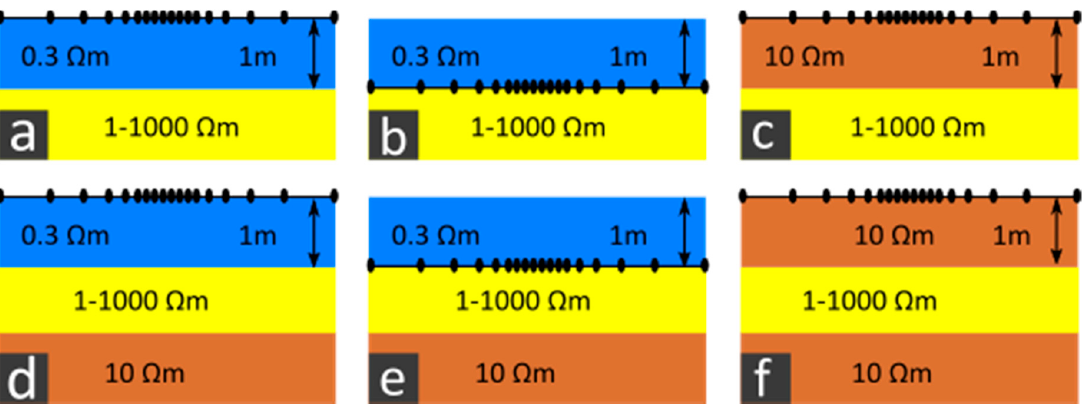
Figure 5. Subsurface models used for forward calculations in the 2L case for ( a ) a shallow water environment, setup F, ( b ) a shallow water environment, setup S and ( c ) an onshore environment, as well as in the 3L case for ( d ) a shallow water environment, setup F, ( e ) a shallow water environment, setup S and ( f ) an onshore environment.